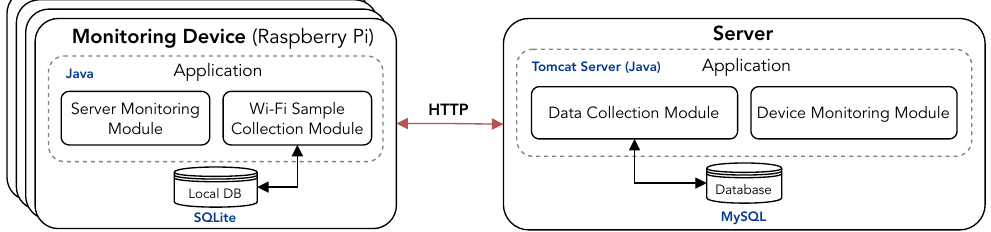
Figure 4. Architecture of the solution for the long-term collection of Wi-Fi